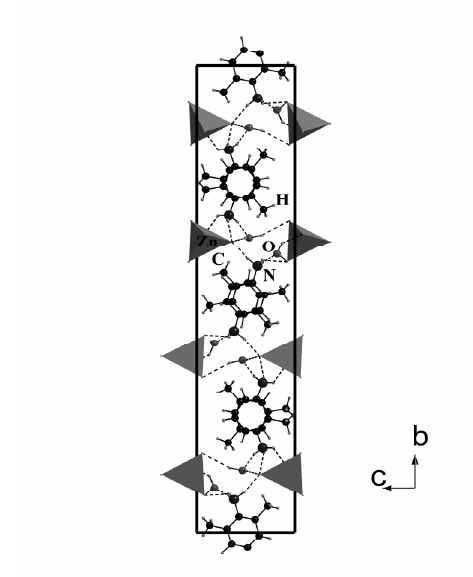
Figure 2. Projection of the [2,6-(CH ZnCl is given in tetrahedral representation. Other atoms are indicated by their symbols. 4 Hydrogen bonds are denoted by dotted